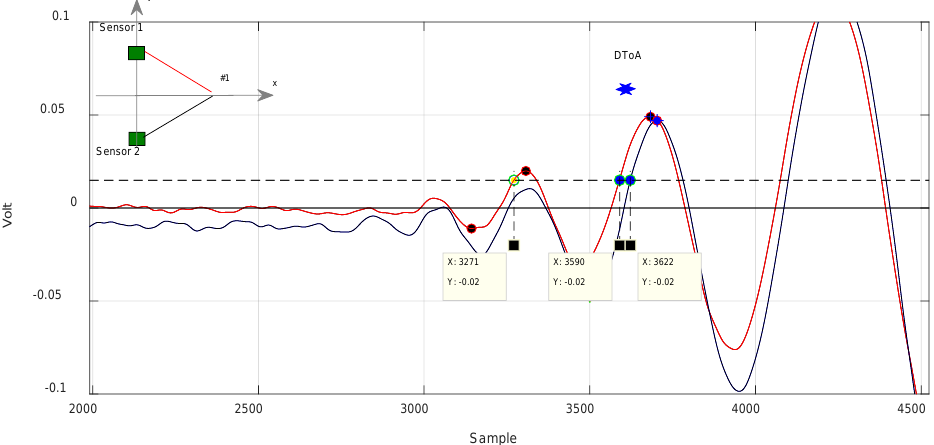
Figure 11. Application of the algorithm to evaluate the DToA in the case of impact along the axis of horizontal symmetry of the sensors. Position #1. Ts = 4 × 10 − 8 s.